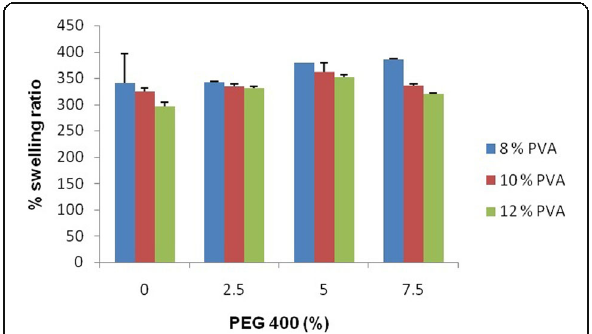
Fig. 4 Effect of concentration of PEG 400 and PVA on percentage swelling ration of the hydrogel sheets, n = 3, mean ±